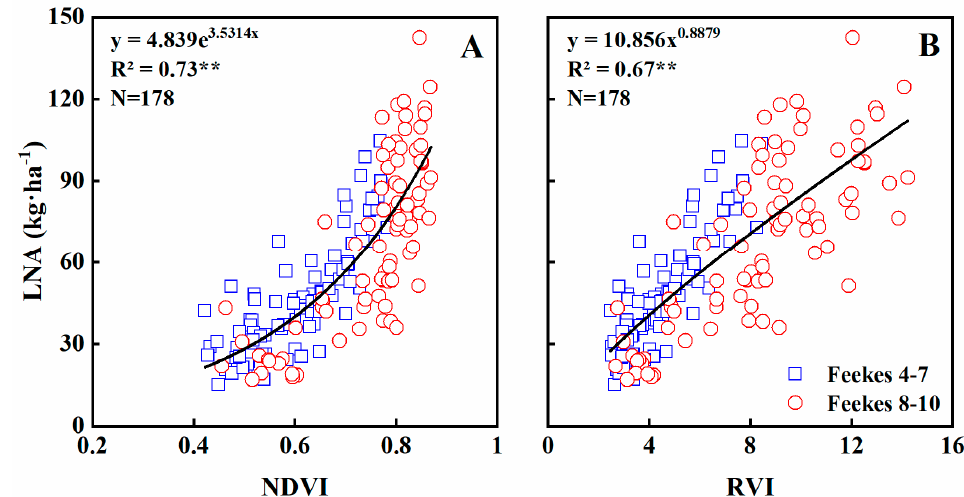
Figure 8. Quantitative relationships of NDVI ( A ) and RVI ( B ) to LNA in wheat varieties under varied N rates across all growth stages.